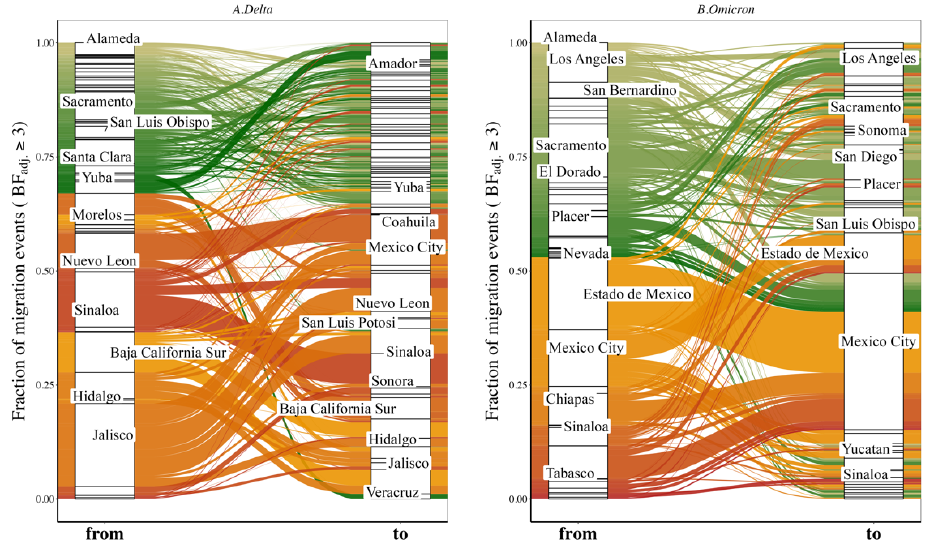
Figure 4. Proportion of viral migration events from each source location (‘from’) toward the recipient location (‘to’) for Delta ( A ) and Omicron ( B ) variants. The Sankey plot shows the proportion of viral migration events from each source location (Californian county or Mexican state) toward the recipient location. Left side of the plot shows the source location (‘from’) and right side of the plot shows the destination location (‘to’). We only report migration events associated with an adjusted Bayes factor (BFadj) ≥ 3. See also Supplementary Figure S7 for results of each of the 10 individual replicates. Locations accounting for ≥ 2% of all events are labeled.